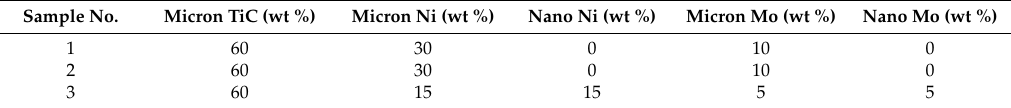
Table 1. Chemical composition of the